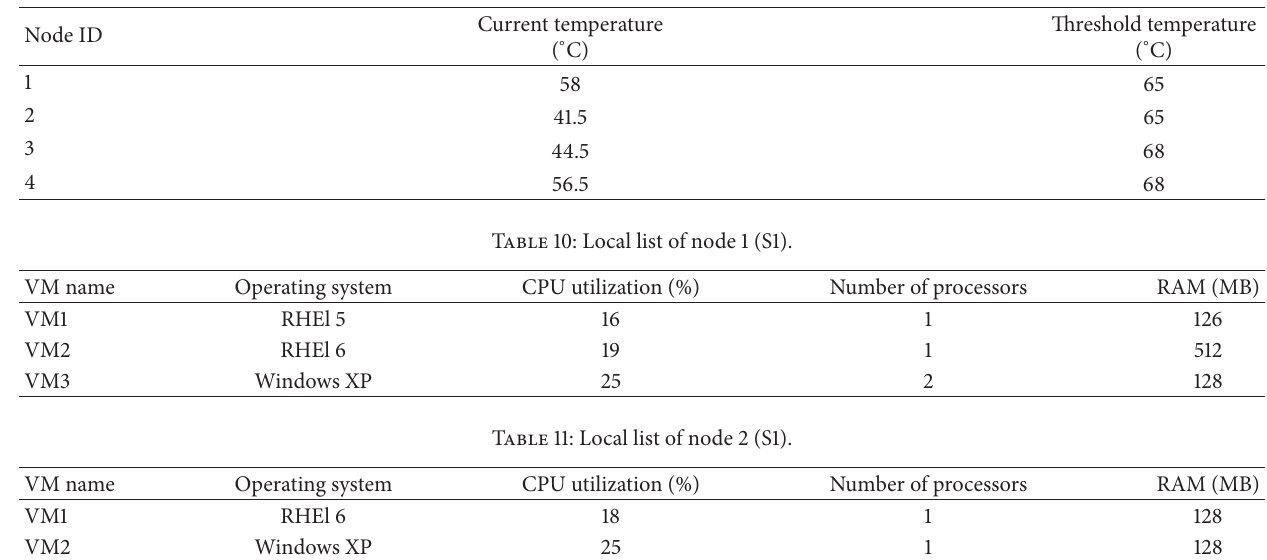
Table 9: Unified list (S1).